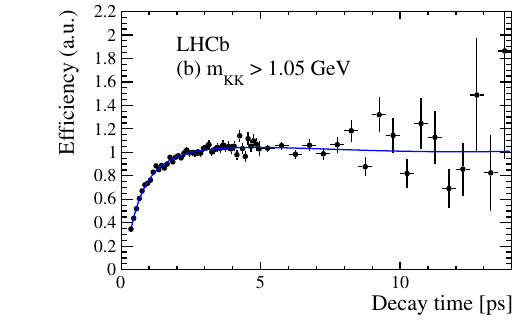
Figure 4 . Scaled decay-time e(cid:14)ciency " B and (b) the high-mass